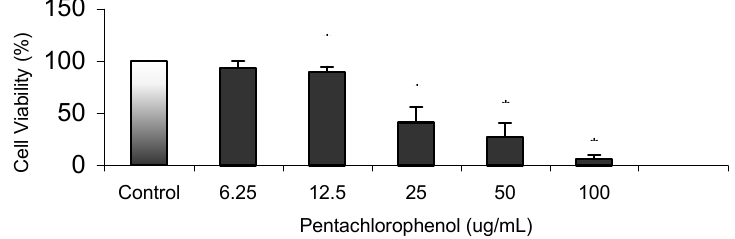
): HepG cells were 2 2